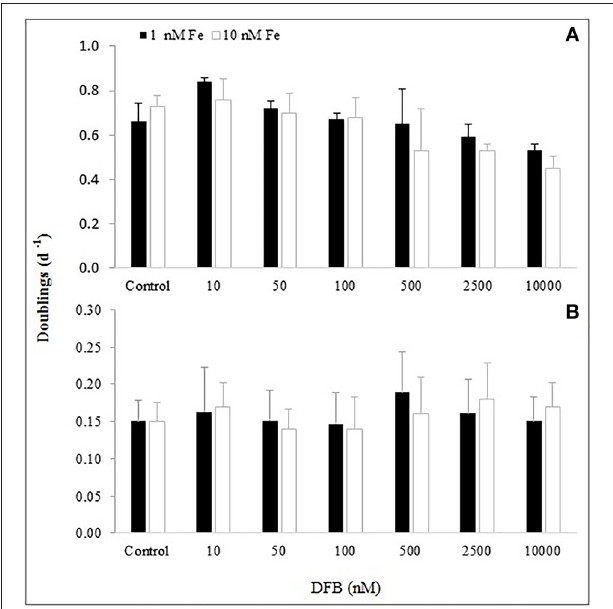
FIGURE 3 | Growth rate (doublings d − 1 ) for (A) the diatom Skeletonema costatum and (B) the dinoflagellate Alexandrium catenella, based on cell density measured at exponential phase (Ln) for each treatment performed with desferrioxamine B (DFB).